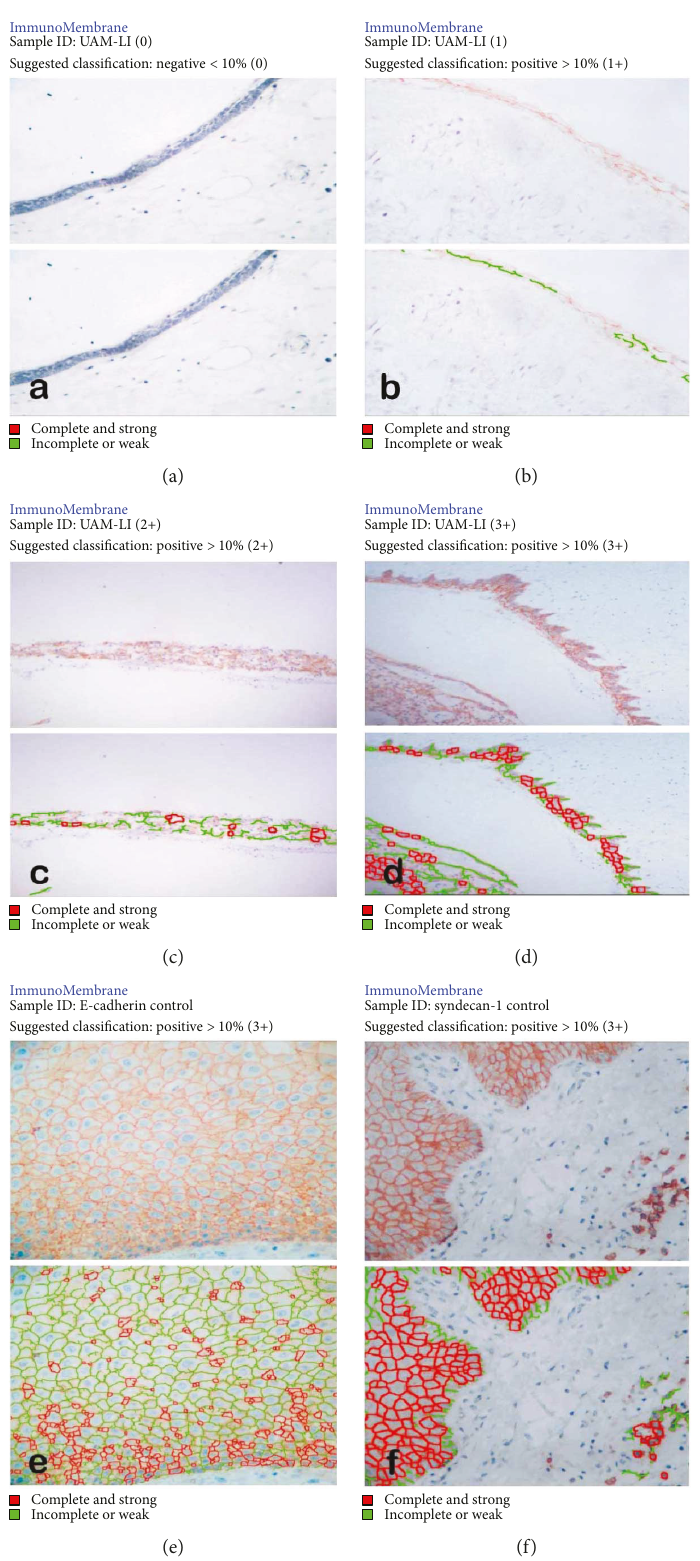
Figure 1: Intraluminal/luminal unicystic ameloblastomas in which the expression of E-cadherin was evaluated using ImmunoMembrane software. (a) Negative (or < 10%) immunostaining, intensity (0); (b) positive ( ≥ 10%) immunostaining, intensity (1+); (c) positive immunostaining, intensity (2+); (d) positive immunostaining, intensity (3+); (e) group control for E-cadherin expression in oral mucosa, positive immunostaining, intensity (3+); (f) group control for syndecan-1 expression in oral mucosa, positive immunostaining, intensity